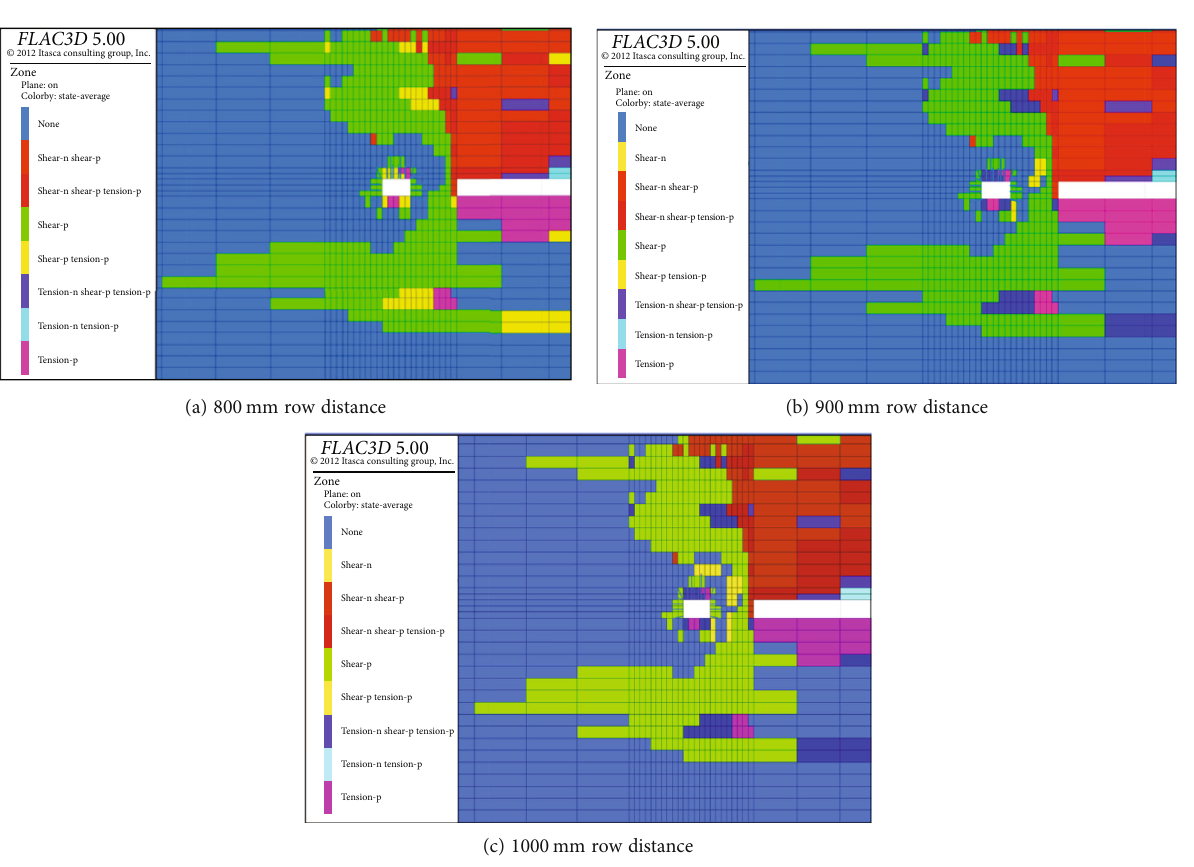
Figure 15: Plastic zone distribution of 8 m width coal pillars and surrounding rock of roadway along goaf under the condition of di ff erent bolt (cable) support row